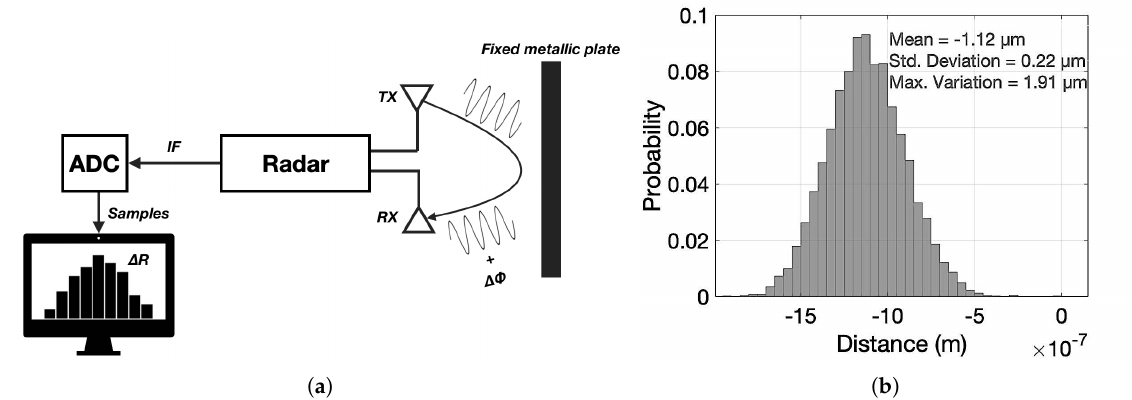
Figure 3. ( a ) Diagram of the measurement set-up for phase stability characterization, where the radar aims at a static metal plate. ( b ) Recorded histogram of the distance displacements due to phase shifts according to φ ( τ i ) = 4 π f c R ( τ i ) / c .